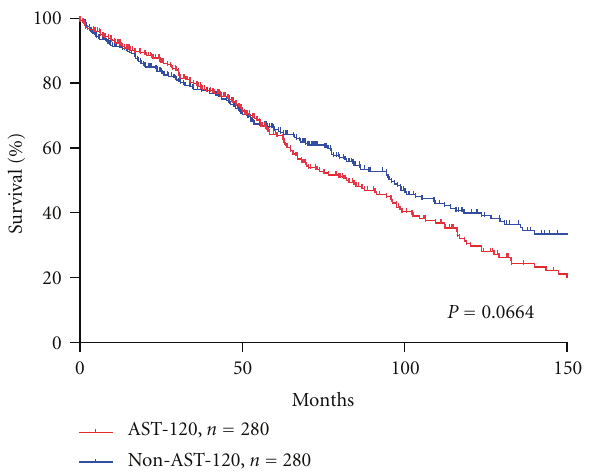
Figure 3: Patient survival rate after the administration of AST- 120. Patient survival rate was not significantly di ff erent in the pair- matched patients with or without AST-120